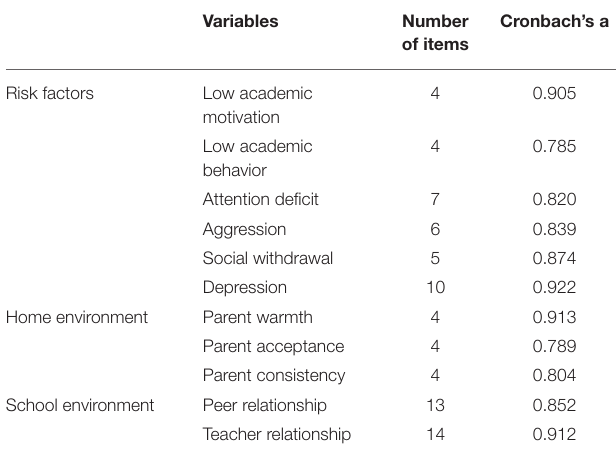
TABLE 1 | The reliability of scales used to measure study